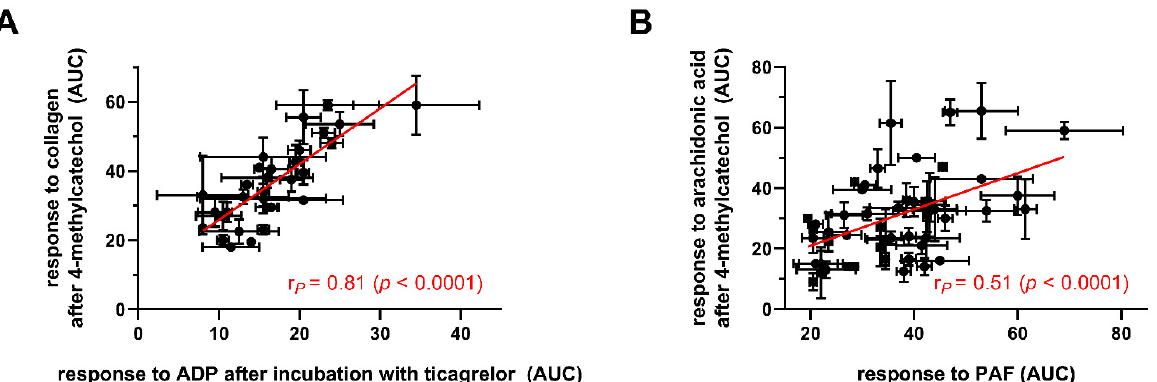
Figure 3. Examples of strong associations between responses to 4-methylcatechol and other inducers/antagonists. ( A ): ADP after ticagrelor incubation with collagen (1 µ g/mL) after 4-methylcatechol (70 µ M) treatment, ( B ): Platelet-activating factor-16 (PAF) with arachidonic acid (200 µ M) after 4-methylcatechol (10 µ M) incubation. ADP—adenosine-5’-diphosphate.